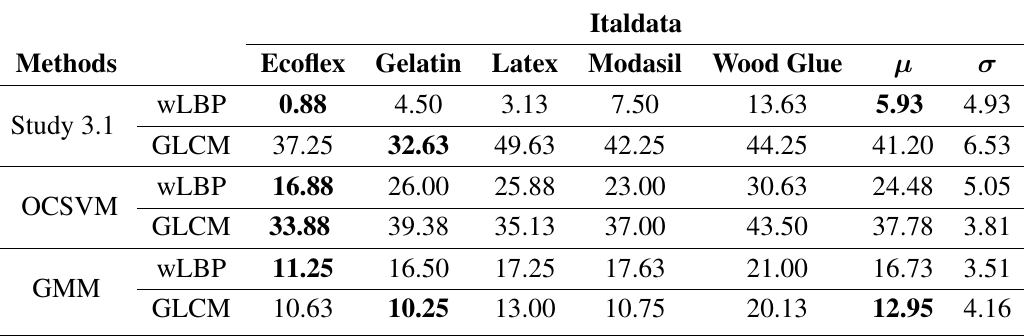
Table 11. ACER for the Italdata dataset, study 3 (ACER in % ).